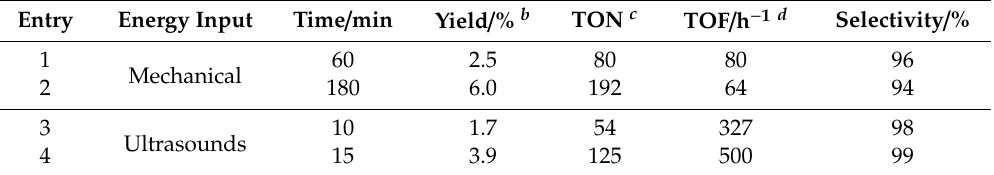
Table 4. Selected catalytic results for the oxidation of 1-phenylethanol into acetophenone using,